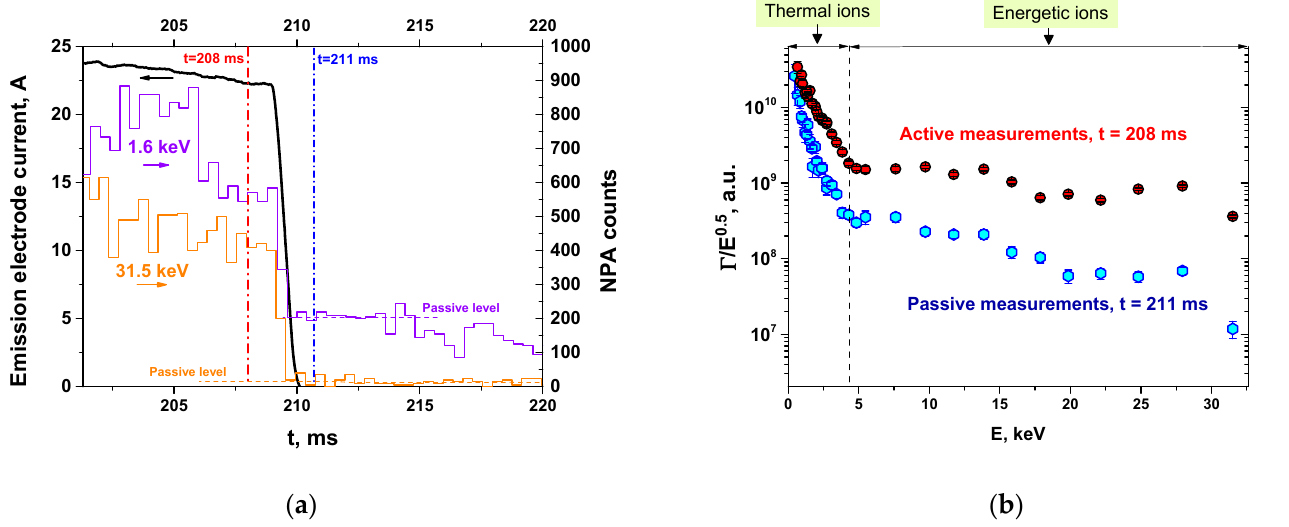
Figure 4. Active and passive NPA signals: ( a ) Variation in the NPA count rate after the 28.6 keV NB injector-1 switch off for the case of 1.6 keV (discharge #41866, violet) and 31.5 keV (discharge #41862, orange) atoms. ( b ) NPA spectra obtained before (active, red circles) and after (passive, blue hexagons) NB injector-1 switch off (discharges ##41862–41866 with similar parameters). The moments of measurements correspond to the vertical dash-dotted lines in figure ( a ). Error bars indicate standard error under the assumption that the number of incident atoms is described by the Poisson distribution.